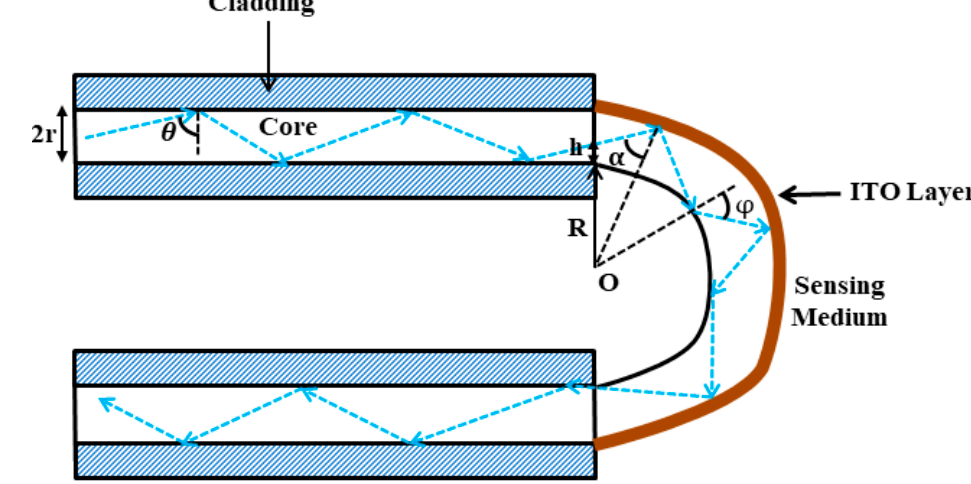
Figure 2. Graphical representation of the proposed ITO-coated U-shaped fiber optic LMR sensor.